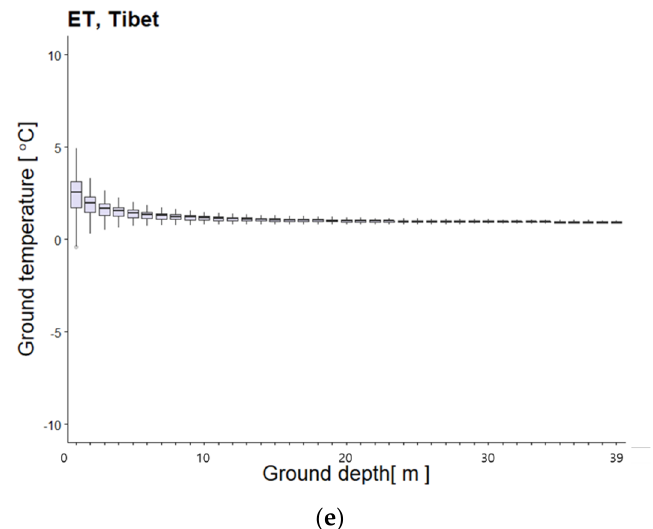
Figure 4. Ground temperatures at different depth: ( a ) as, Indore; ( b ) BSk, Beijing; ( c ) Cfa, Buenos Aires; ( d ) Dfd, Yaktsk; ( e ) ET, Tibet.